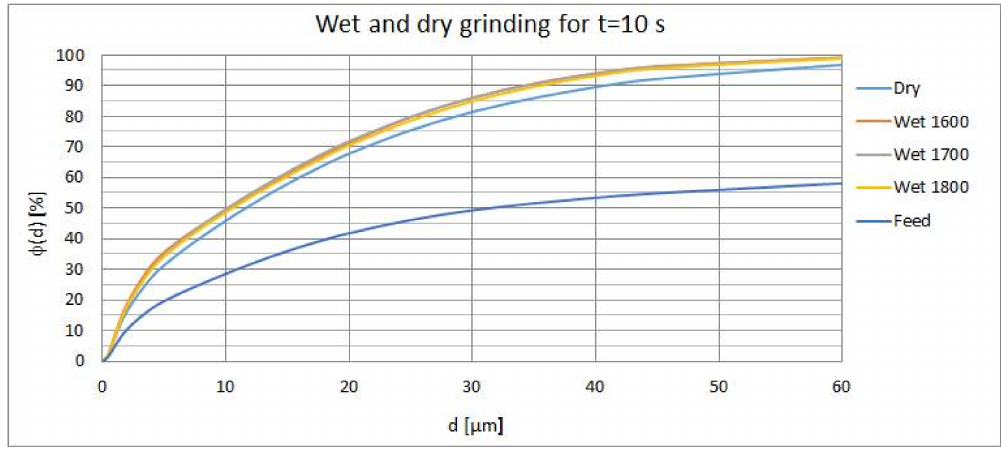
Figure 17. Comparison of cumulative volume curves for dry and wet grinding process (t = 10